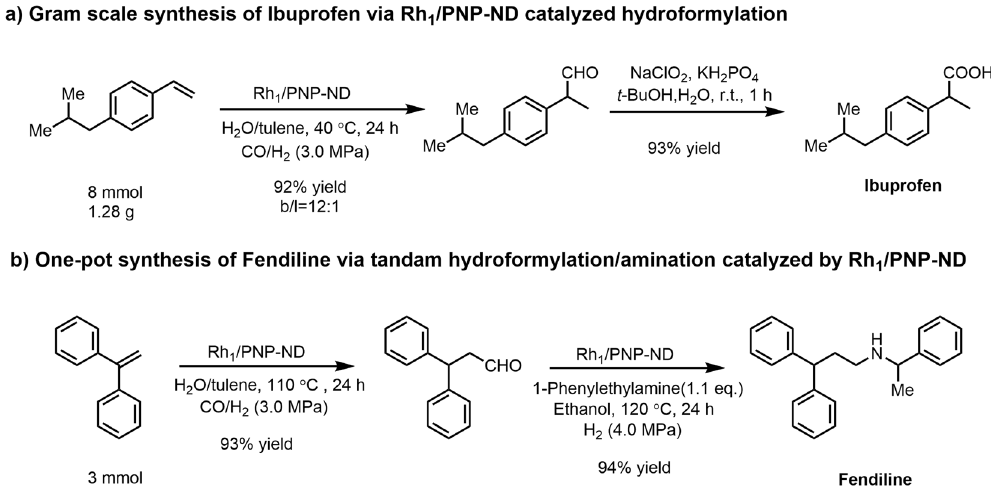
Fig. 8 The synthetic routes for Ibuprofen and Fendiline via Rh1/PNP-ND catalyzed hydorformylation. a For the hydroformylation step, 200 mg Rh 1